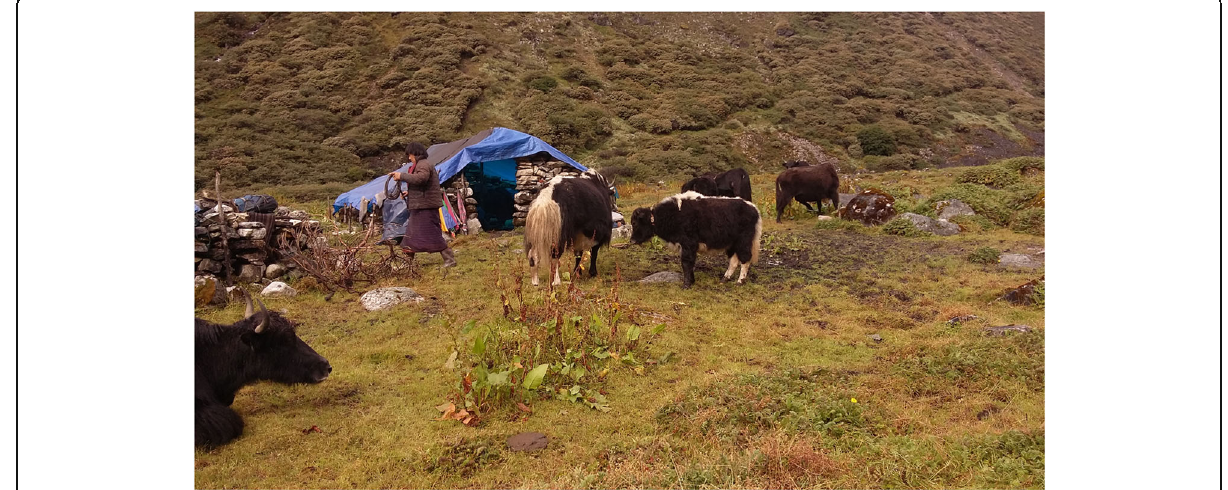
Figure 1 Tsamdro is refered to a native grazing